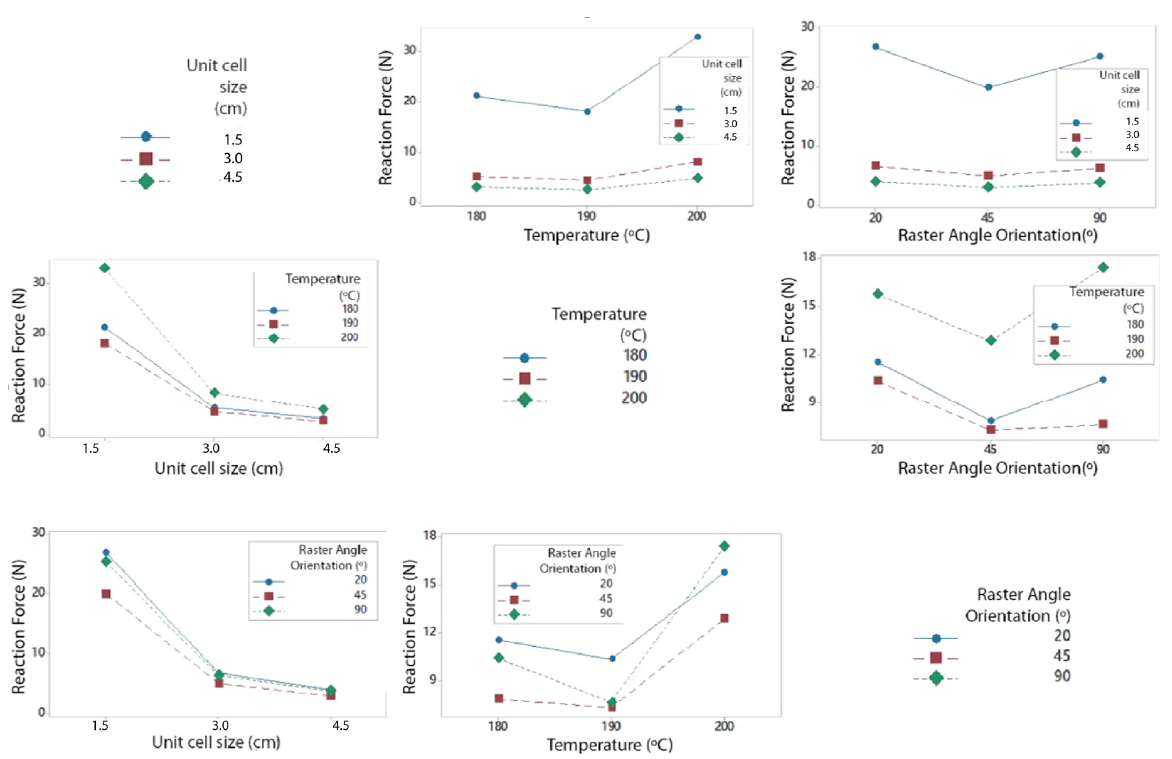
Polymers 2021 , 13 , x FOR PEER REVIEW